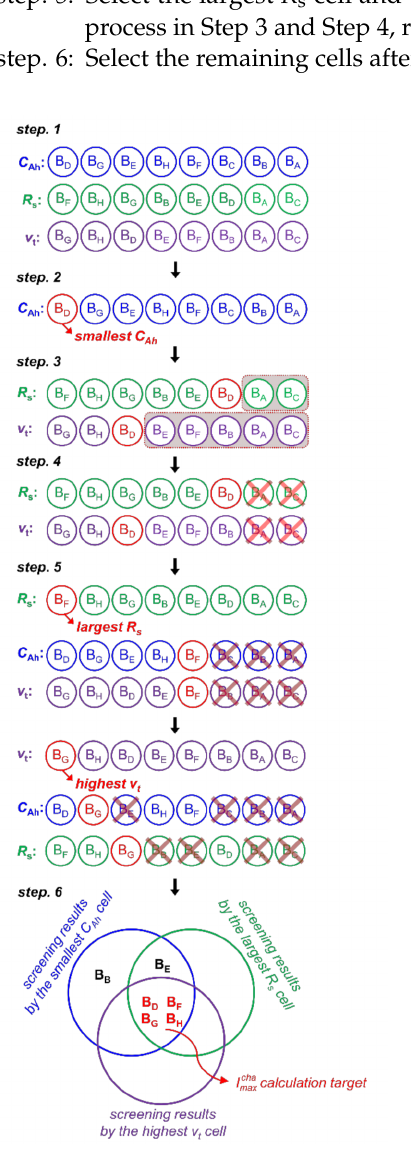
Figure 8. Operating principle of the second screening process according to Steps 1–6. The I cha of the cells selected in Step 6 are calculated, and the final I cha of the battery max max pack is determined as the minimum magnitude (B H ). Thus, the proposed algorithm can manage all the cells, such that V upper is not exceeded without an additional output restric- tion, and it can reduce the complexity because I cha is calculated only for the selected max